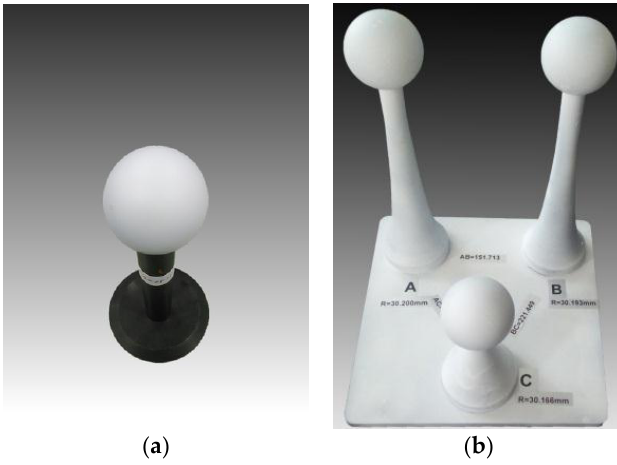
Figure 6. The balls that are already measured by a coordinate measurement machine (CMM) for the tank experiments. ( a ) The standard ball whose precise radius and spherical error are known for the accuracy test. ( b ) The three balls fixed on the one base board for the spatial error test. The radii of the three balls and the distances between any two balls are accurately known.